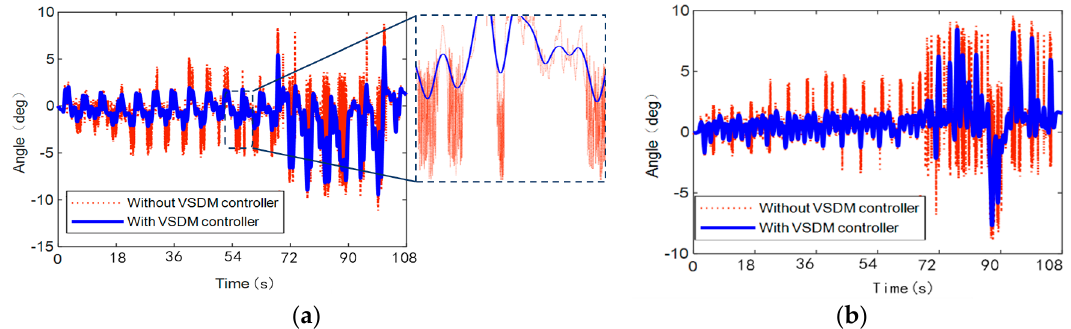
Figure 20. The observed values of pitch angle and roll angle: ( a ) Curve of pitch angle, and ( b ) curve of roll angle.